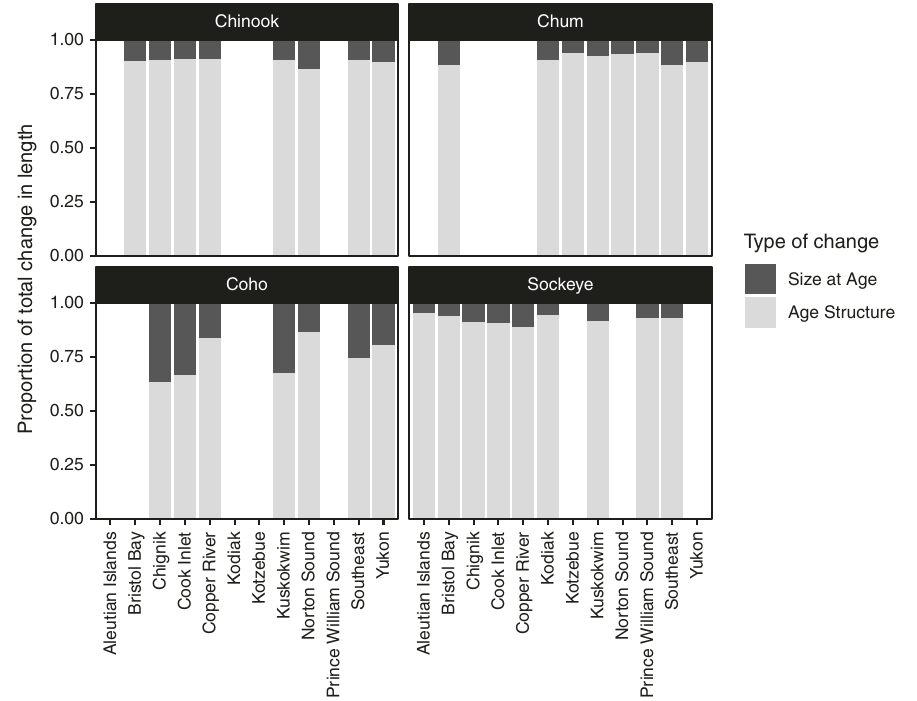
Fig. 3 Body size declines result primarily from shifting age structure. Changes in population mean length are primarily due to changing age composition (gray) and to a much lesser extent changing size-at-age (black). For each population the mean among-year contribution was calculated, then region means calculated from population-level means. Sample sizes are presented in Supplementary Data